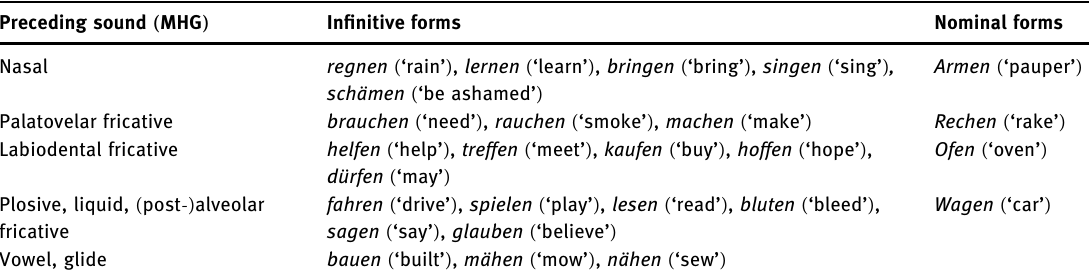
Table 2: Items chosen for analysis Preceding sound ( MHG ) In fi nitive forms Nominal